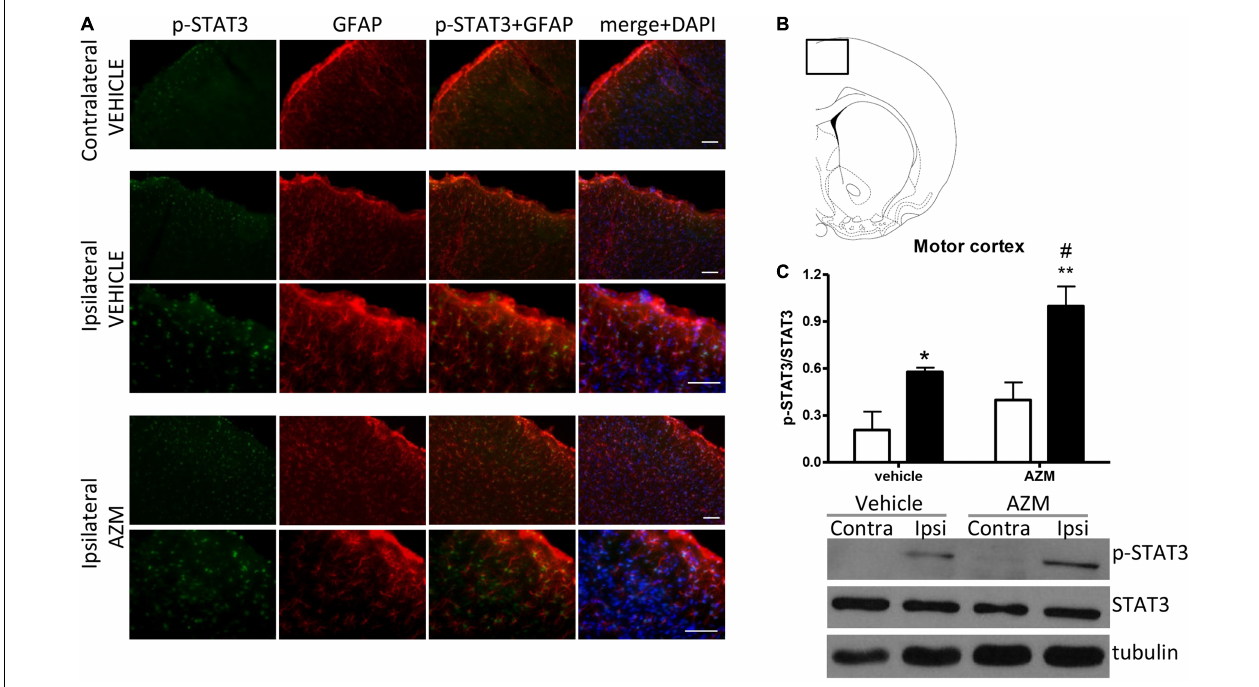
FIGURE 2 | Azithromycin elevates STAT3 phosphorylation in the motor cortex of rats subjected to 2 h MCAo followed by 2 h of reperfusion. (A) Representative immunofluorescence images of the contralateral and ipsilateral (ischemic) motor cortex (inset in B ) of rats subjected to transient MCAo, showing expression of p-STAT3 in most GFAP-positive astrocytes and other DAPI-positive cells (likely resembling pyramidal neurons) in the lesioned hemisphere. Scale bars = 70 µ m. (C) Western blot analysis of phospho-STAT3 (Tyr705) (p-STAT3), total STAT3, and tubulin performed on brain homogenates from the ipsilateral (Ipsi, dark bars) and contralateral (Contra, white bars) motor cortex. Rats were treated with vehicle (0.9% NaCl) or azithromycin (AZM, 150 mg/kg), i.p., upon reperfusion. Data from the densitometric analysis of the autoradiographic bands are expressed as mean ± SEM of four independent experiments ( n = 4 rats per experimental group); ∗ P < 0.05 vs. vehicle contralateral; # P < 0.05 vs. AZM contralateral and ∗∗ P < 0.01 vs. vehicle ipsilateral (two-way ANOVA for repeated measures followed by Bonferroni